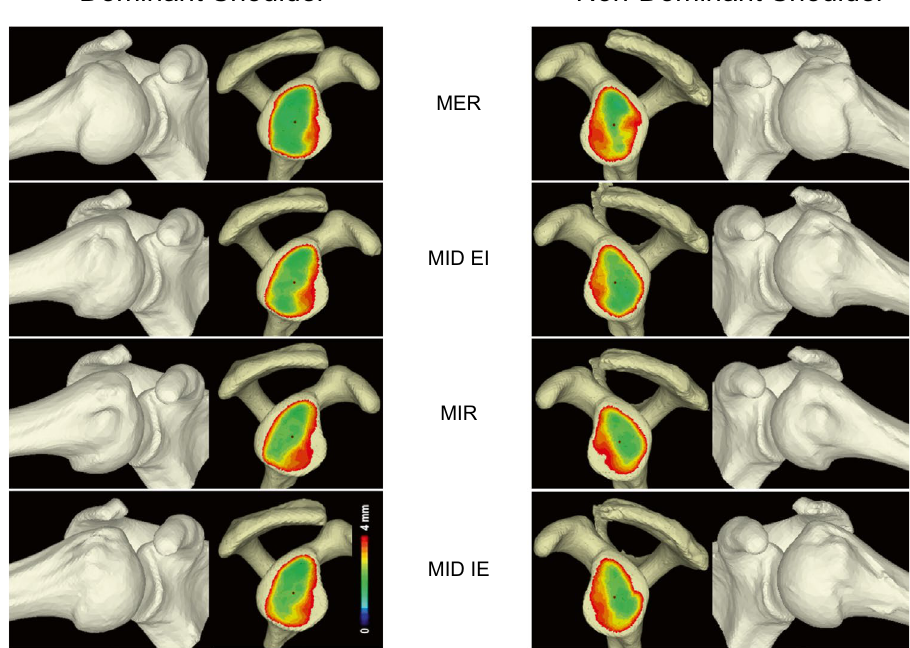
Figure 3. The averaged bone models and glenohumeral contact area. Black dot, center of glenohumeral contact area; MER, maximum external rotation; MIR, maximum internal rotation; MID EI, midpoint from MER to MIR; MID IE, midpoint from MIR to